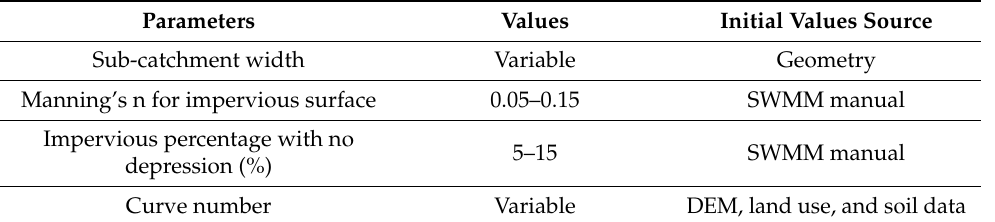
Table 1. SWMM parameters used for the sensitivity analysis.